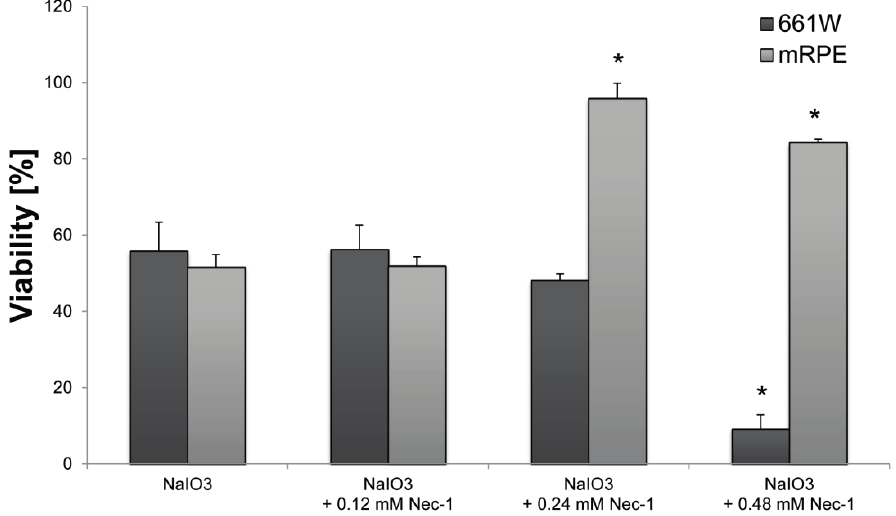
Figure 7. Necrostatin-1 is cytoprotective for NaIO 3 -treated RPE cells. Cell viability of 6 mM NaIO 3 -treated RPE cells was significantly increased after incubation with 0.24 (viability: 96%) and 0.48 mM Nec-1 (viability: 84%) compared to the control (viability: 51%). In contrast, the 661W cells were not rescued by the Nec-1 treatment. * p <